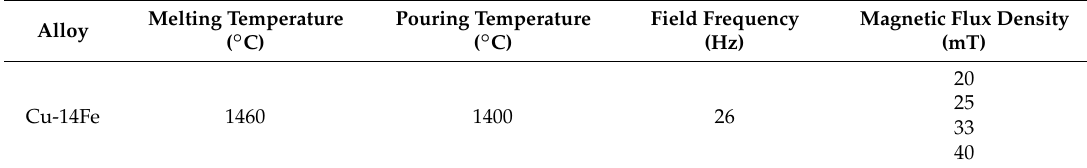
Table 1 . Parameters of Cu ‐ Fe alloys solidified with AMF. Table 1. Parameters of Cu-Fe alloys solidified with AMF.